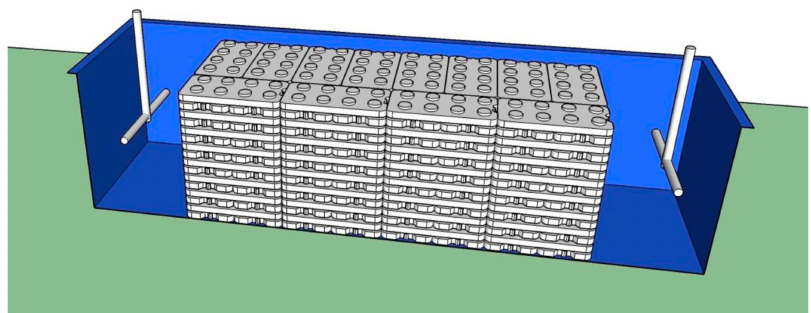
Figure 2. PCM storage tank 3D